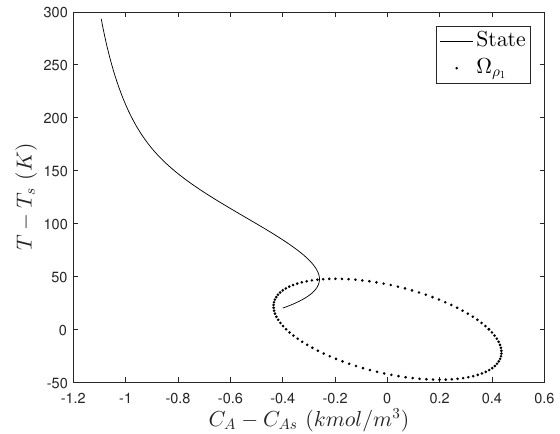
Figure 2. State-space trajectory showing the state trajectory in 10 sampling periods with the falsified state measurements determined through optimization applied at every sampling time, in the absence of